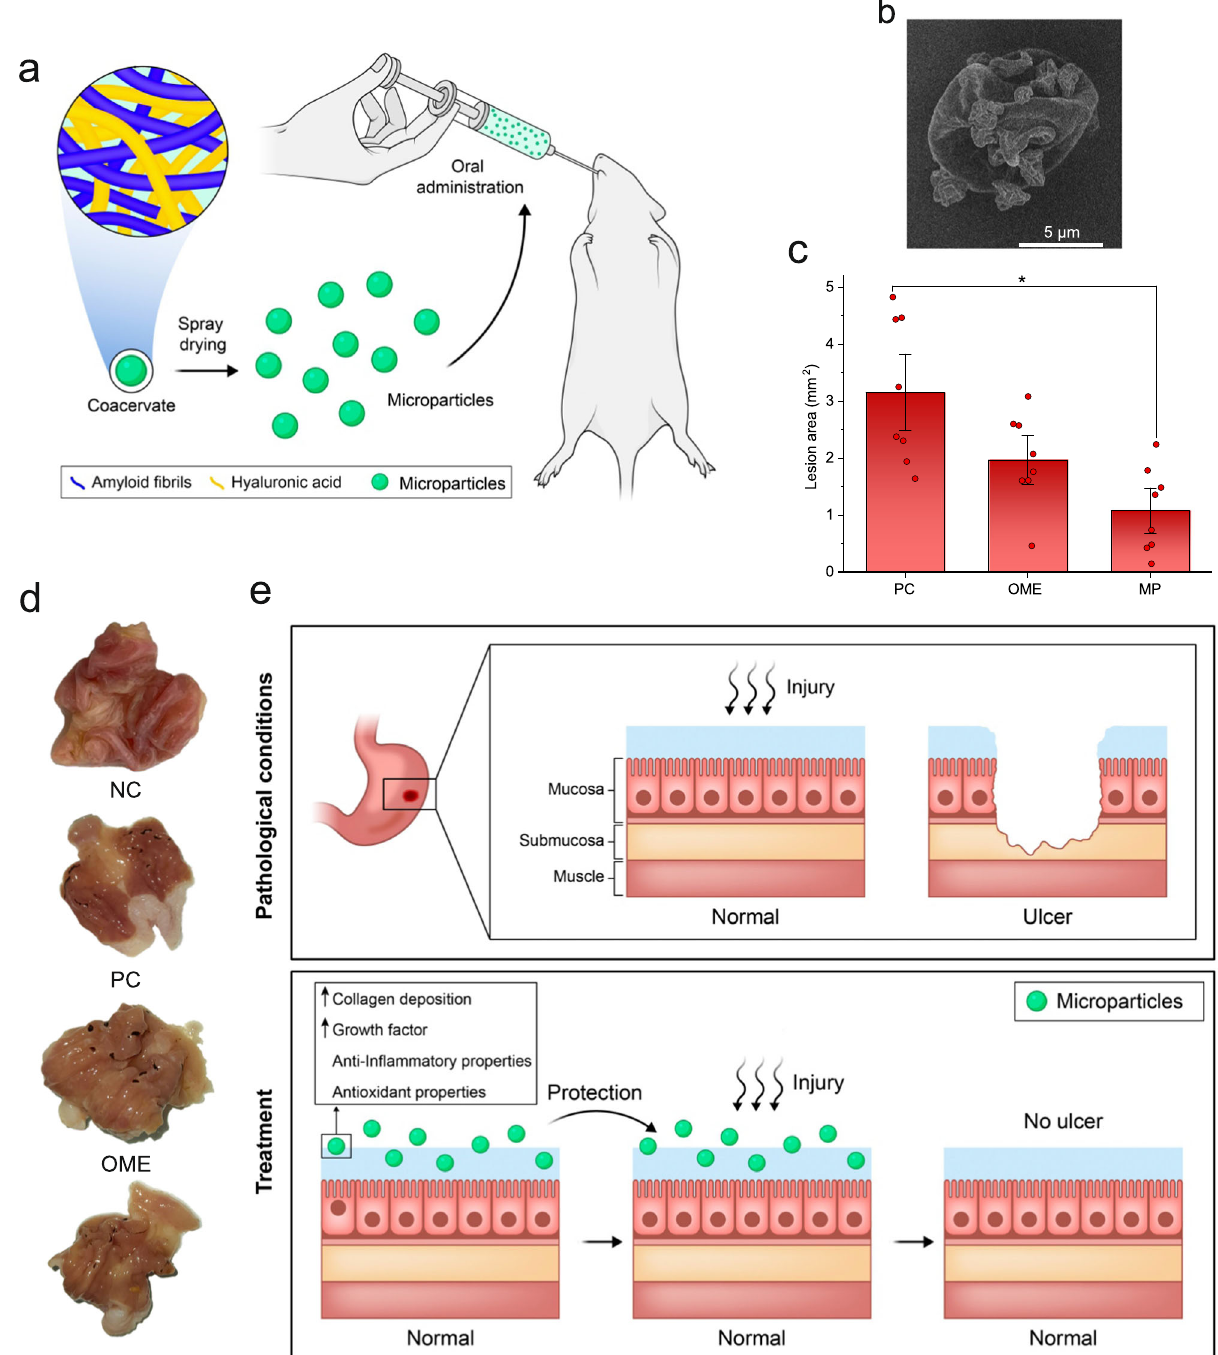
Fig.4|AF-HAcoacervatetherapeuticapplication.a Schematicrepresentationof thedevelopmentofmicroparticlesandtheirapplicationintheinvivoassay. b FEG- SEM images of spray-dried AF-HA microparticles. The FEG-SEM experiment was repeatedatleastthreetimesandarepresentativeimagewasshown. c lesionareaof the gastric ulcer in rats and ( d ) macroscopic photo images of representative